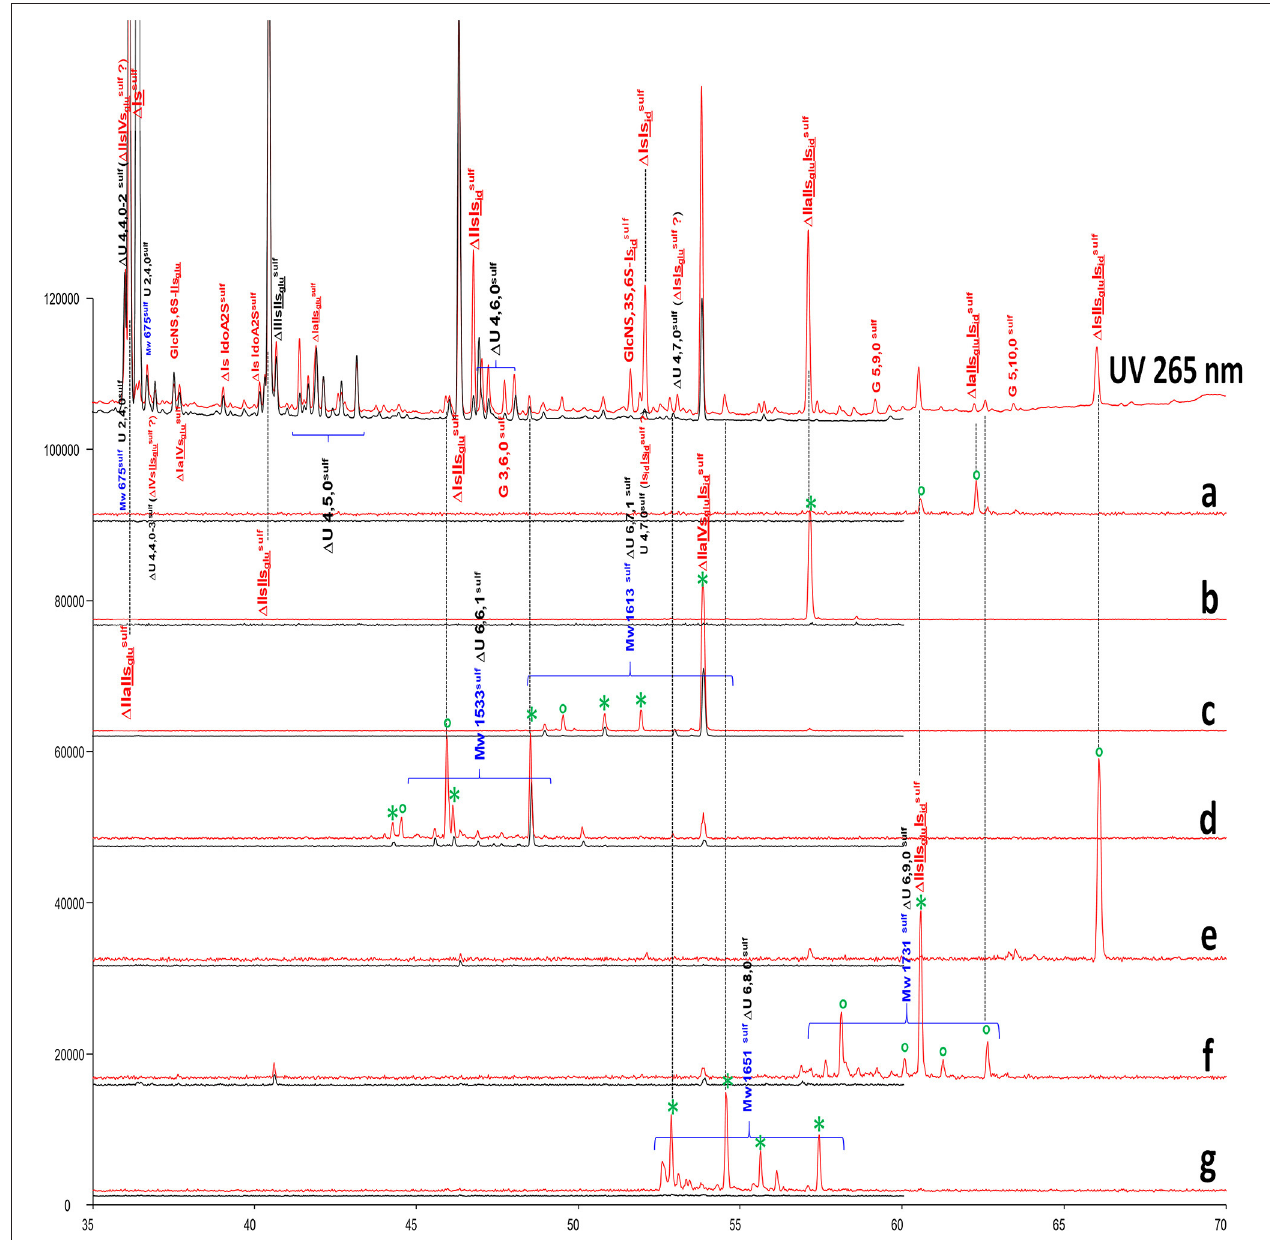
FIGURE 9 | Comparison by ion-pair liquid chromatography/mass spectrometry (LC/MS) of heparinase I + II + III ( — ) and heparinase II ( — ) digests of bovine mucosal heparin high-affinity (HA5) fraction after sulfanilic reductive amination. (a) Reconstructed ion pair chromatograms (RIC) 1 U(6,9,1) sulf : m/z 1252.3; (b) RIC 1 U(6,8,1) sulf : m/z 1154.3; (c) RIC 1 U(6,7,1) sulf : m/z 1056.7; (d) RIC 1 U(6,6,1) sulf : m/z 959.2; (e) RIC 1 U(6,10,0) sulf : m/z 1271.6; (f) RIC 1 U(6,9,0) sulf : m/z 1173.3; (g) RIC 1 U(6,8,0) sulf : m/z 1075.7. *Digested by 1 4 − 5 glycuronidase; ◦ digested by 1 4 − 5 2- O -sulfatase.